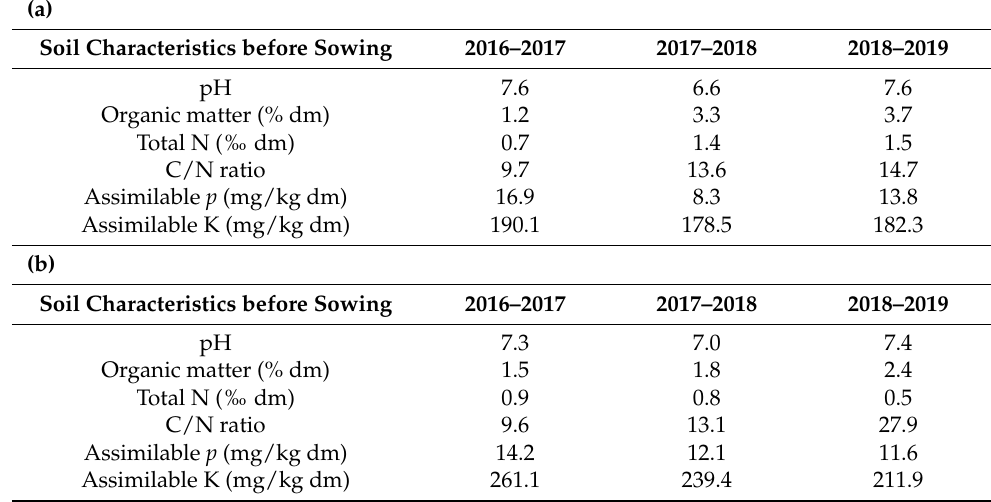
Table 6. Soil parameters prior to sowing for years and growing areas (a), Italy; (b) USA. The soil parameters were supplied by Agriparadigma Laboratories (Ravenna,